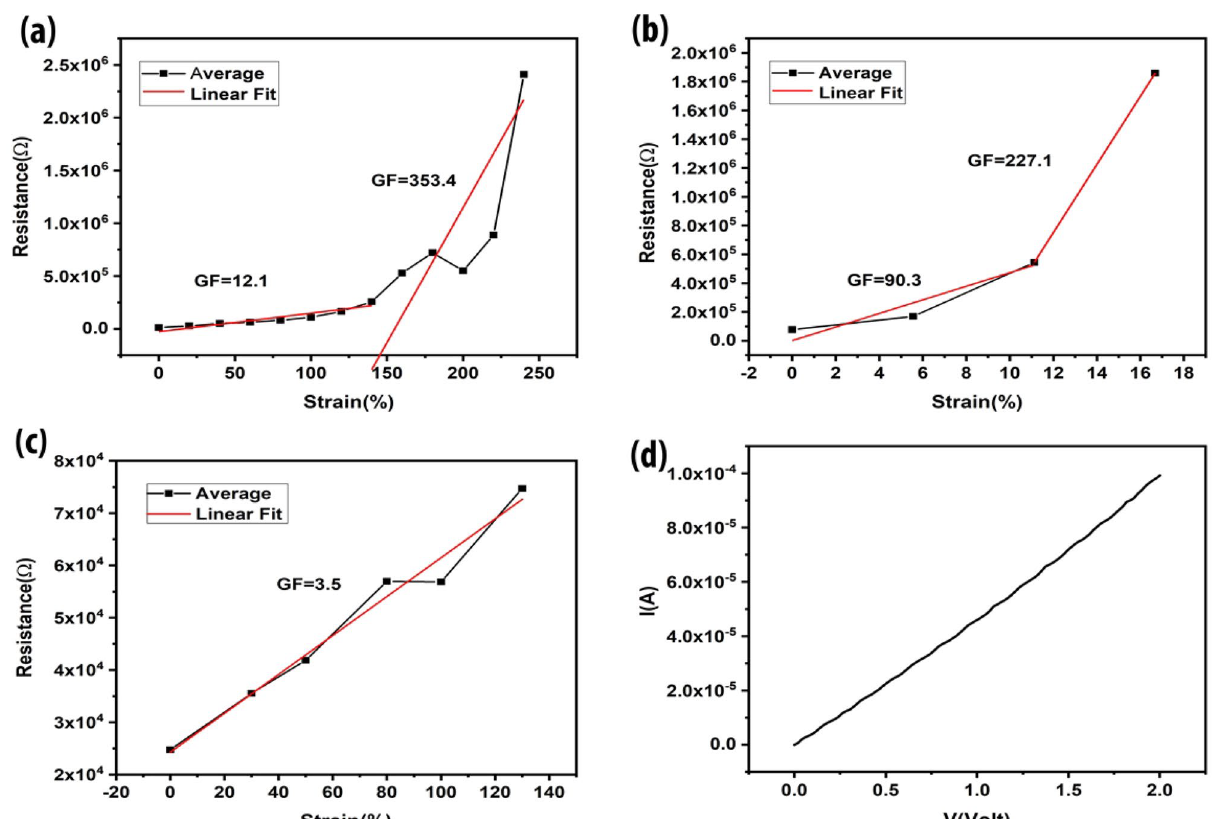
Figure 4. Device characterization of Stretching, Bending and Torsion. Graphs show the resistance change vs. strain percent. ( a ) An average behaviour of the device shows two ranges separated by linear fit after stretching. ( b ) Torsion also shows two sensing ranges: GF for lower range is 90 and higher range shows GF of 227. ( c ) Bending shows a very linear increase in resistance throughout the sensing range while connection breaks suddenly when the sensing limit was reached. ( d ) Current vs voltage graph without any load applied to the